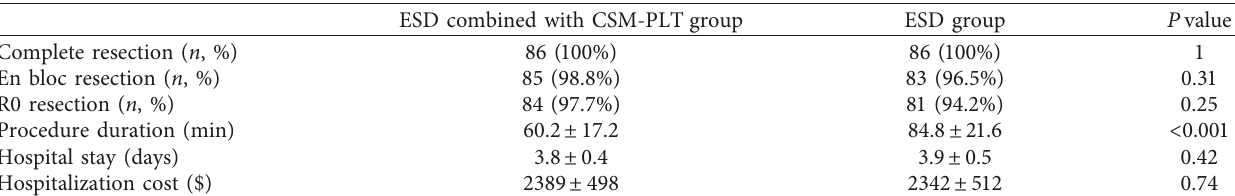
Table 2: Clinical outcomes.